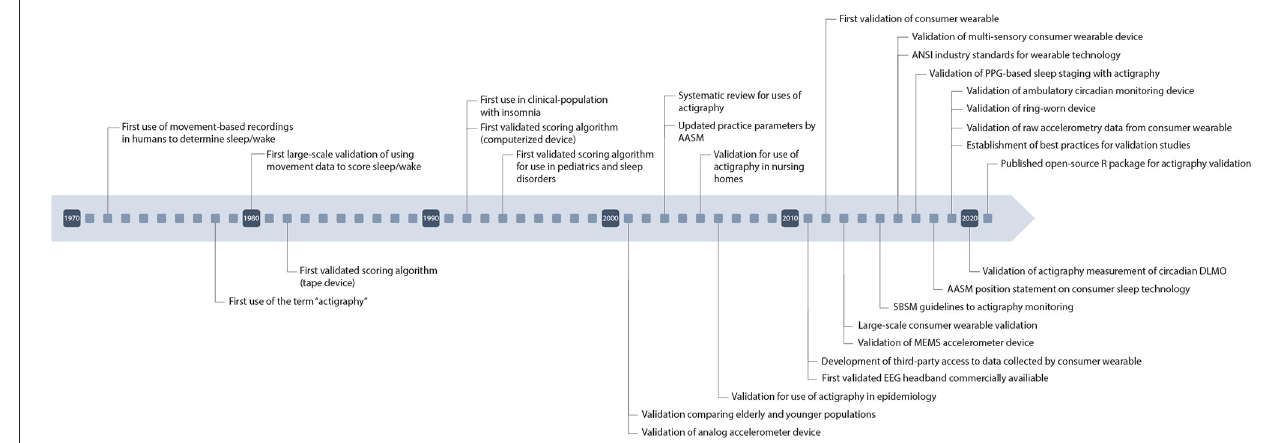
FIGURE 1 | Timeline of major developments in wearable technology.